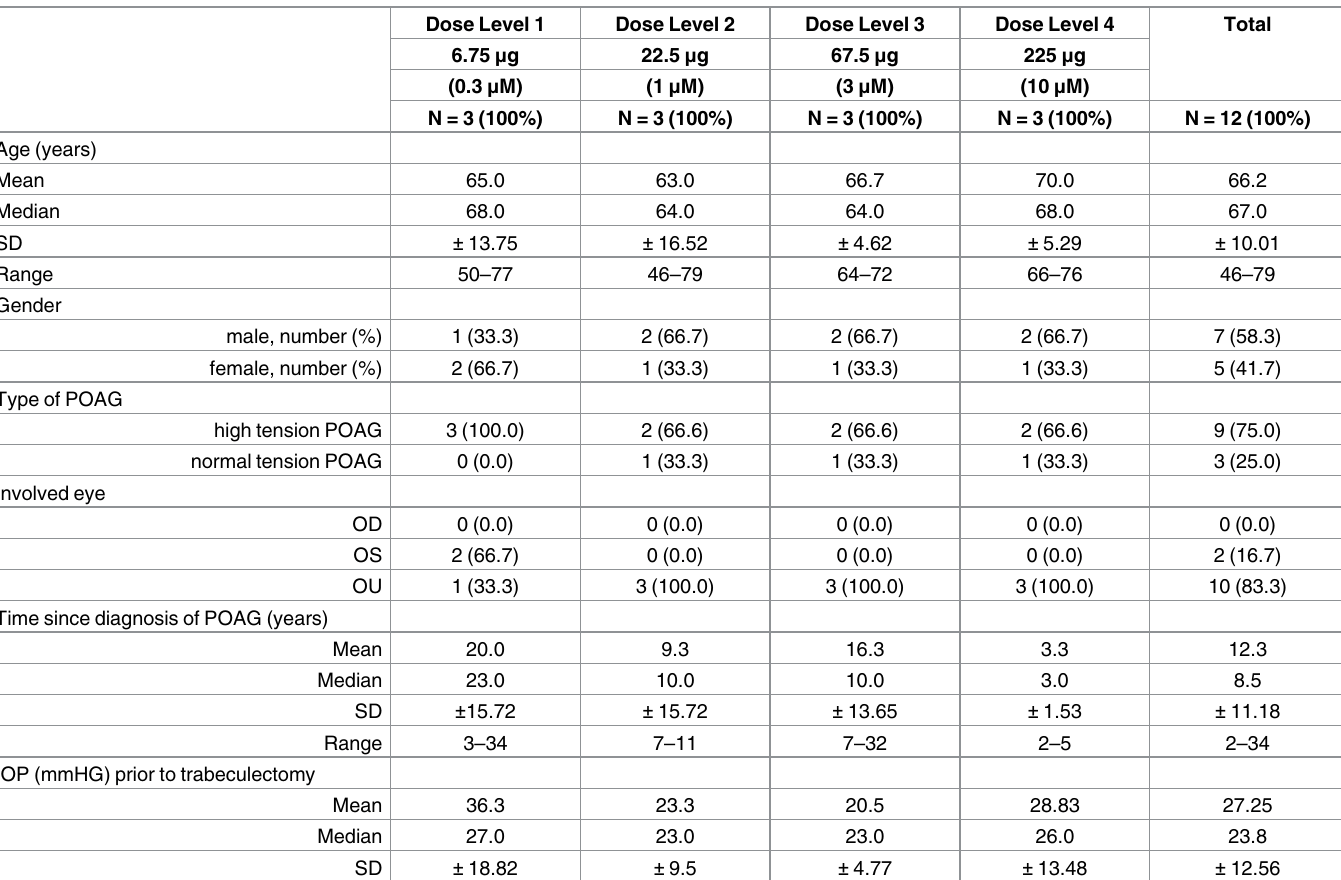
Table 1. Demographics.